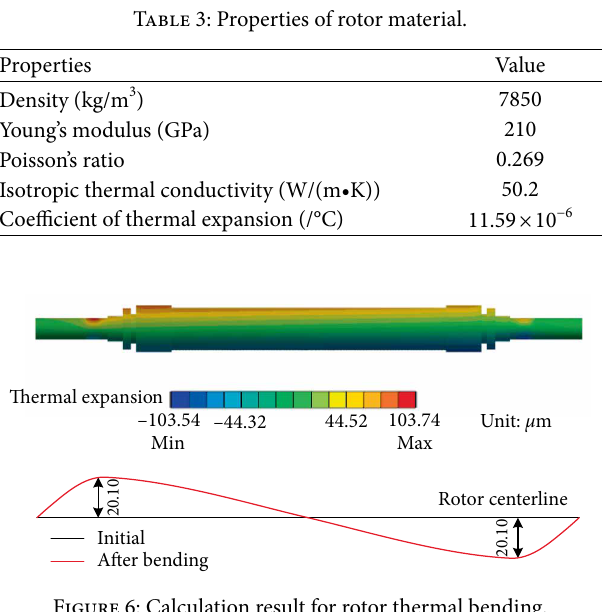
Figure 6: Calculation result for rotor thermal